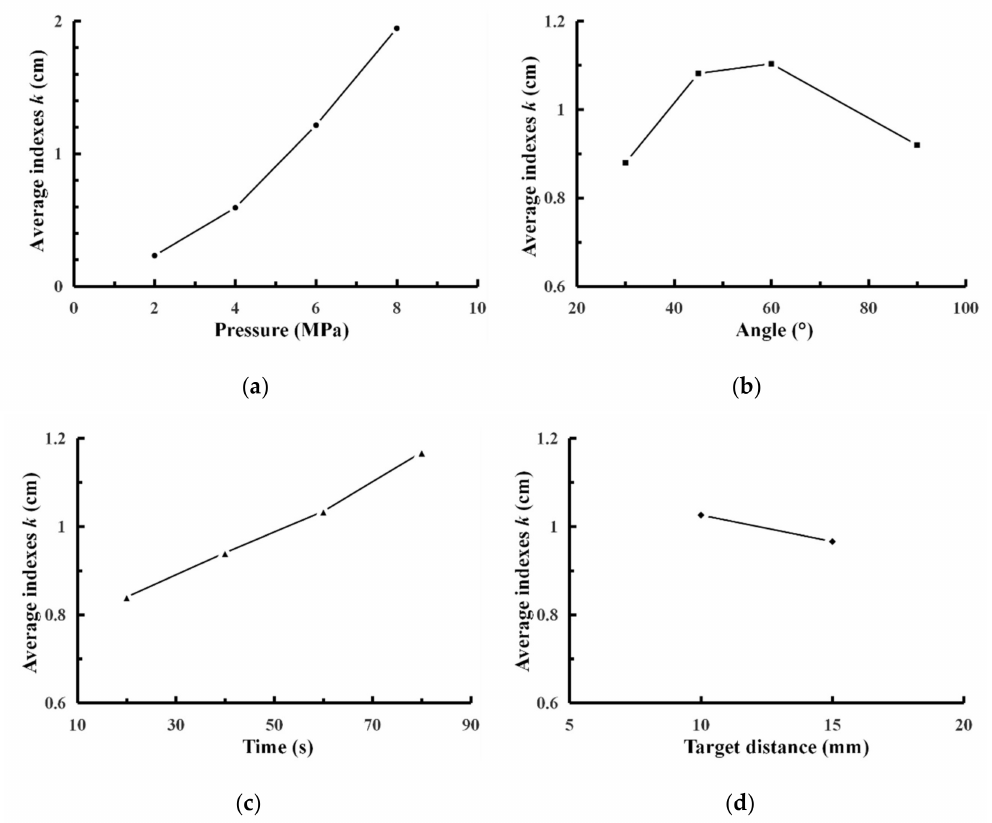
Figure 5. Trend chart of the average indexes k i of erosion depth. ( a ) Jet pressure, ( b ) jet angle, ( c ) impact time, ( d ) stando ff